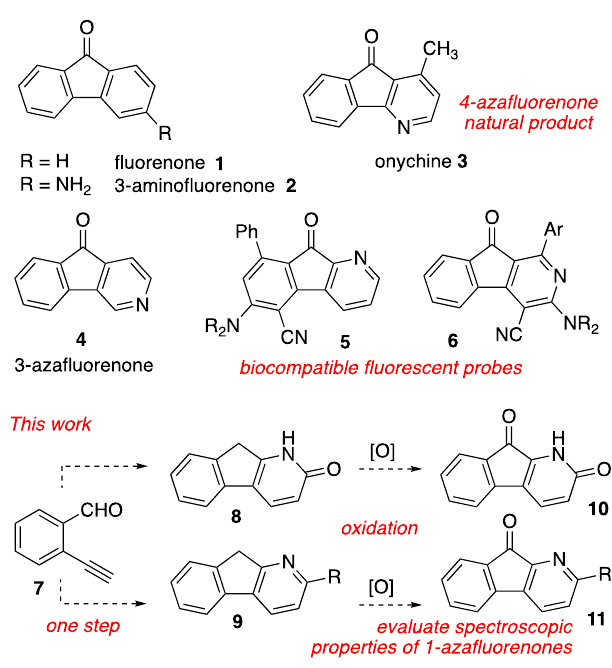
Figure 1. Fluorenone derivatives and the proposed synthesis and evaluation of 1-azafluorenones.